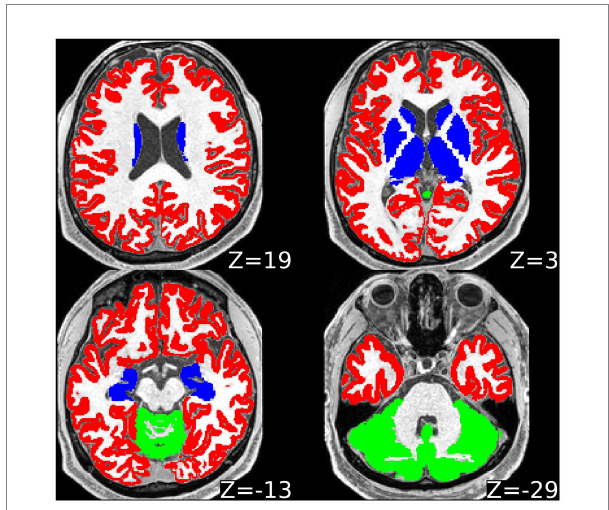
FIGURE 1 Visualisation of regions of interest from one representative subject in axial plane. Slice coordinates in the z axis provided, with zero reference level in the middle of the anterior commissure and posterior commissure line. Red = cortical grey matter; blue = subcortical grey matter; green = cerebellar cortical grey matter. White matter region of interest not marked in a specific